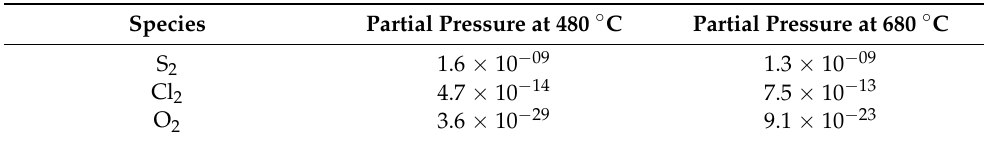
Figure 1. Scheme of the testing equipment for high-temperature corrosion tests in hot gas atmospheres simulating a thermal cracking process [16,17]. Table 1. Partial pressures of sulfur, chlorine and oxygen of the given atmosphere at 480 ◦ C and at 680 ◦ C